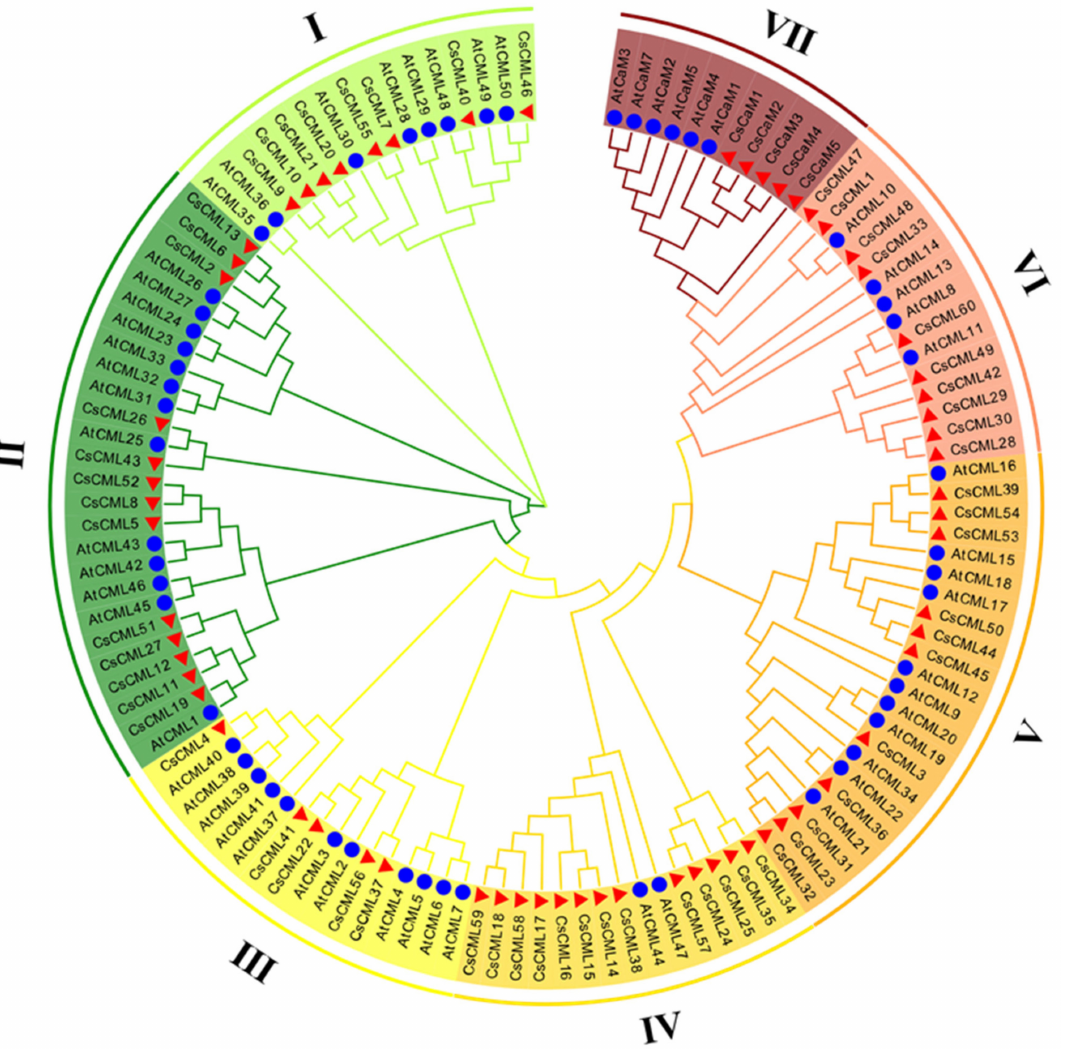
Figure 3. Phylogenetic analysis of Camellia sinensis and Arabidopsis CaM and CML proteins. A total of 65 CaM and CML proteins from tea (5 CaMs and 60 CMLs) and 57 from Arabidopsis (7 CaMs and 50 CMLs) were aligned using DNAMAN. The phylogenetic tree was constructed using the MEGA 7.0 program by the neighbor-joining method with bootstrap values 1000 using protein sequences. The red triangles represent Camellia sinensis . The blue circles represent Arabidopsis